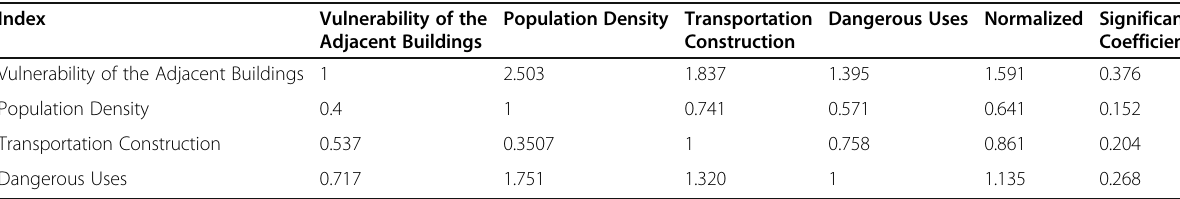
Table 5 Paired comparison matrix of the safety indices